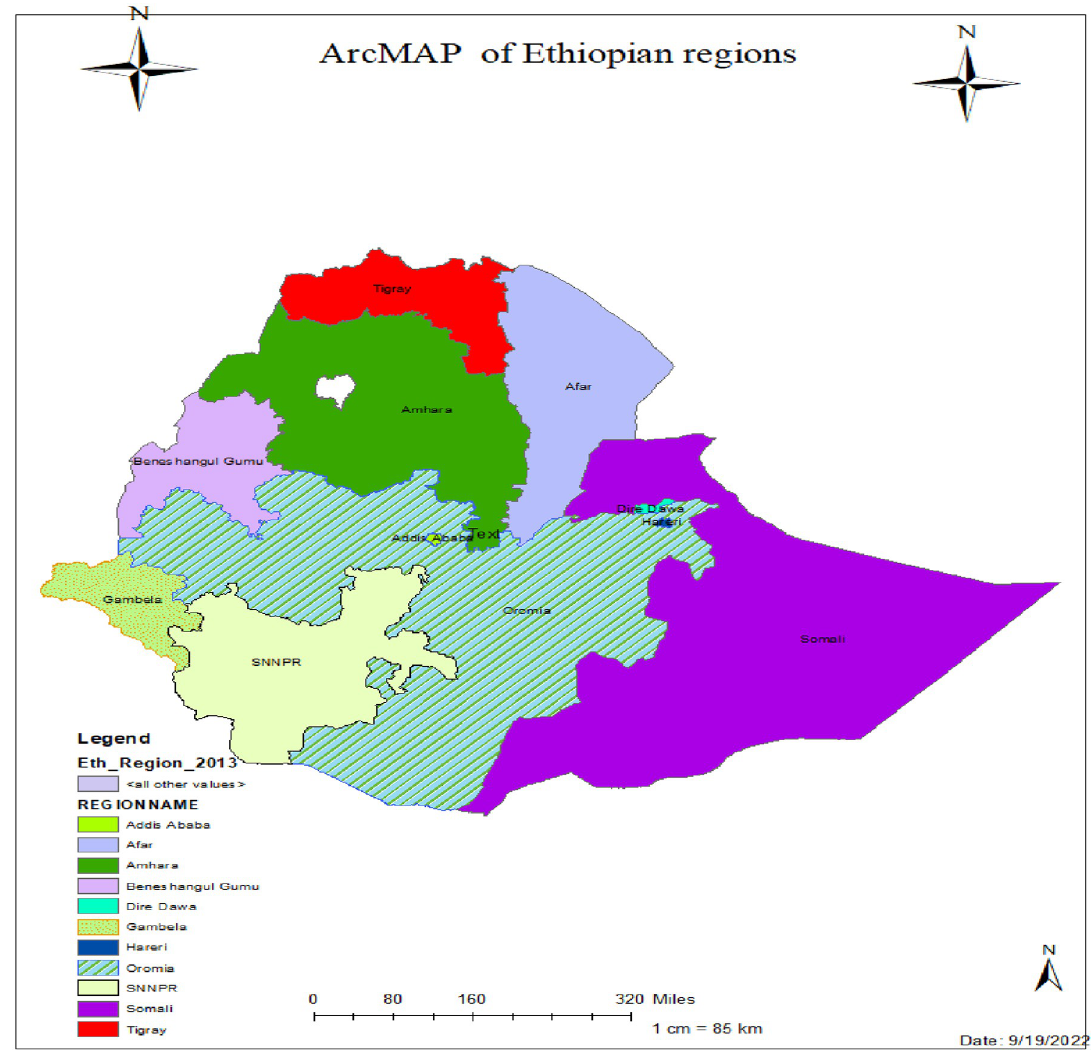
Fig 1. ArcMap of the study areas used to assess utilization status of deworming medication among pregnant mothers in Ethiopia,